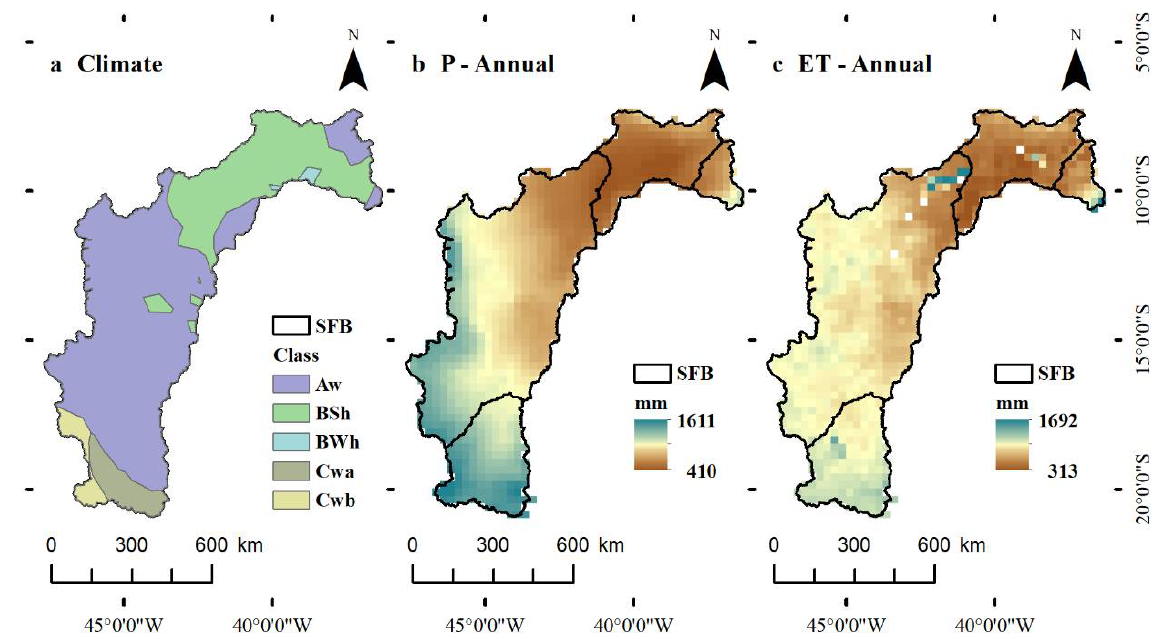
Figure 2. The spatial distribution of: ( a ) the climate type according to Köppen’s classification; ( b ) annual mean precipitation (P); and ( c ) annual mean evapotranspiration (ET) over the Sao Francisco Basin